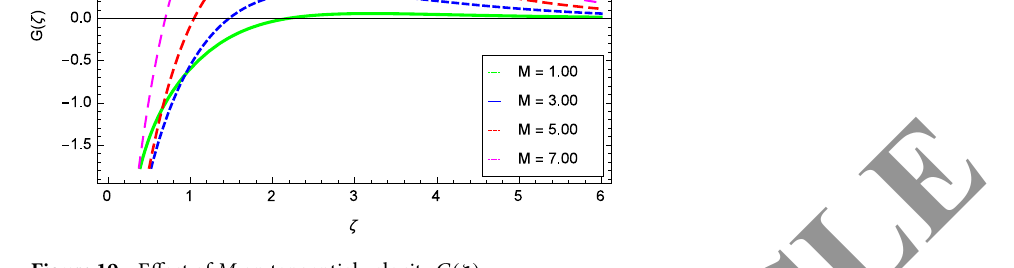
Figure 19. Effect of M on tangential velocity G (ζ) .